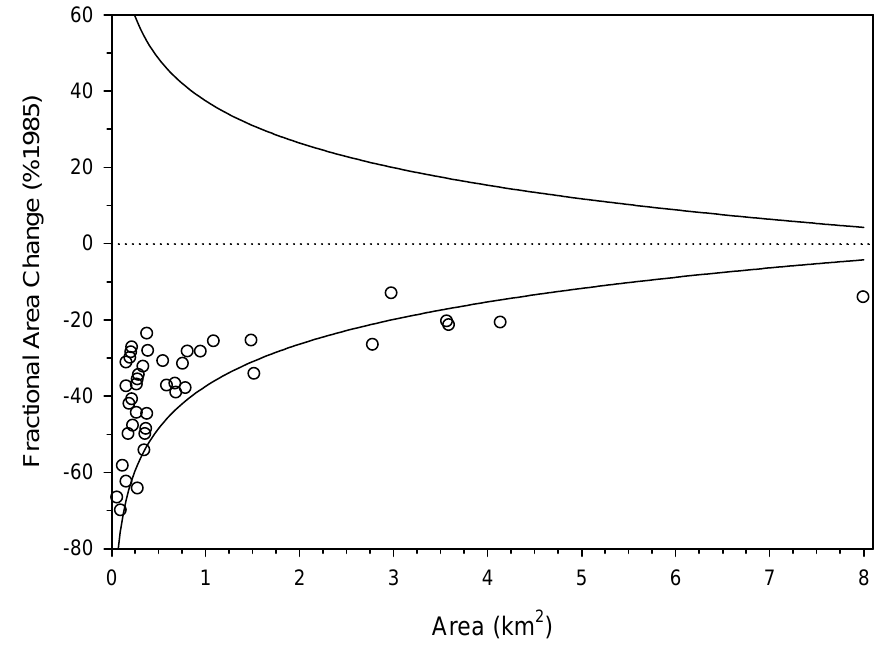
Figure 2. Individual glacier Fractional Area Change (FAC) as a percent of 1985 area. The open circles represent the 42 individual glaciers while the solid lines represent the error envelope about the